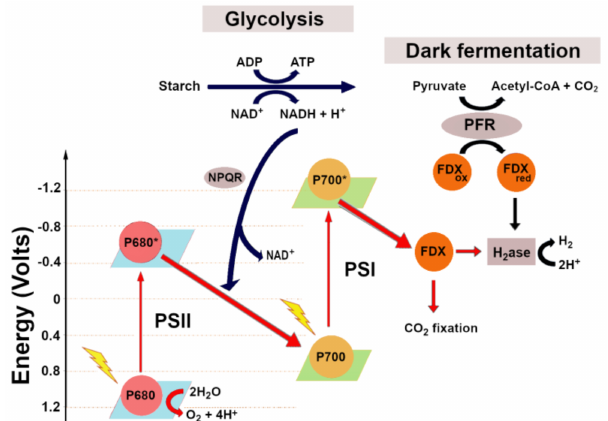
Metabolic hydrogen production pathways used by Chlamydomonas reinhartii .FDX: ferredoxin; H 2 ase: hydrogenase; NPQR: NADPH − plastoquinone oxidoreductase; PFR: pyru- vate:ferredoxin oxidoreductase; PSI: photosystem I; PSII: photosystem